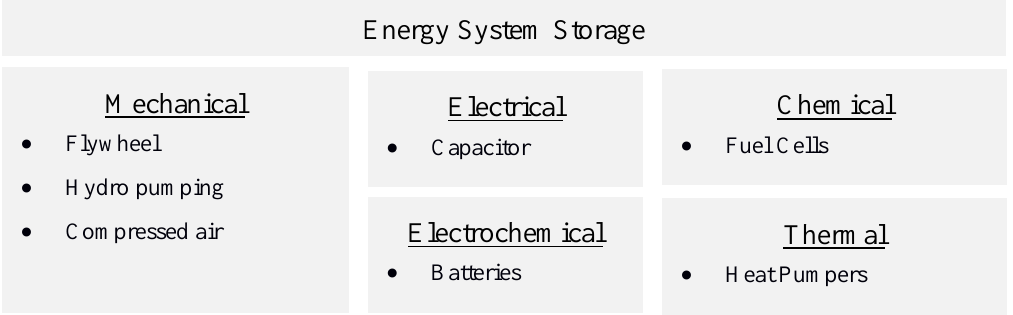
Figure 1. Classification of storage systems (adapted from [28]).